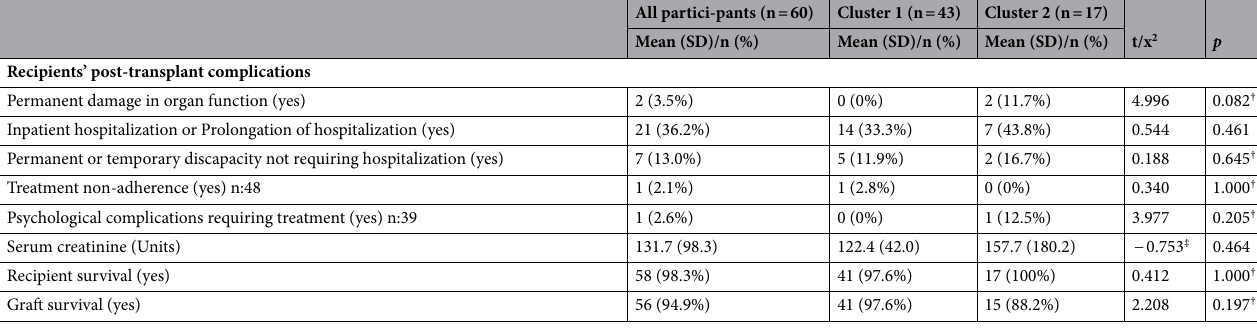
Table 3. Post-donation characteristics and differences between clusters. † Fisher’s exact test. ‡ Not assuming equality of variances. § SF-36 T scores (> 55 is higher than average, < 45 is lower than average).